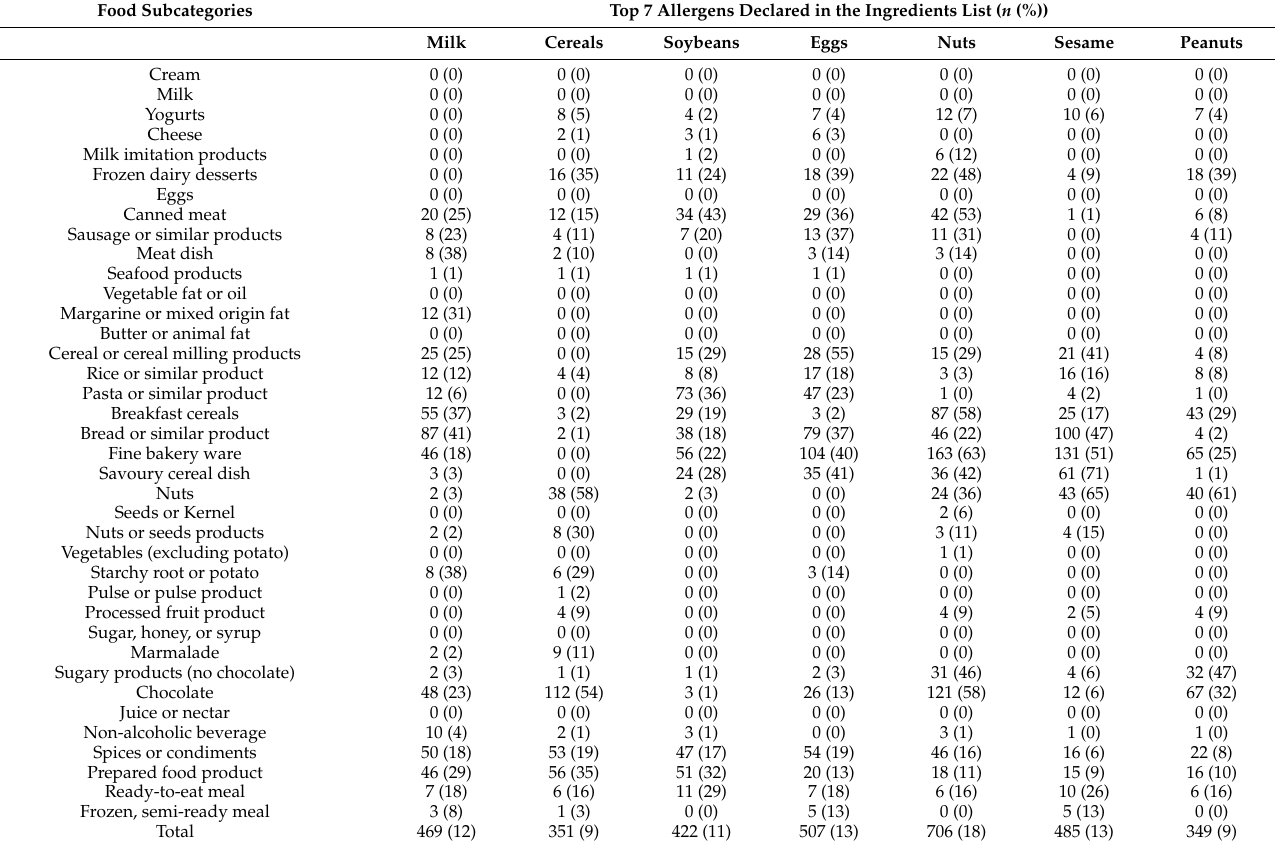
Table 4. Prevalence of the most commonly declared allergens in a precautionary statement among the 3859 products in HelTH per food